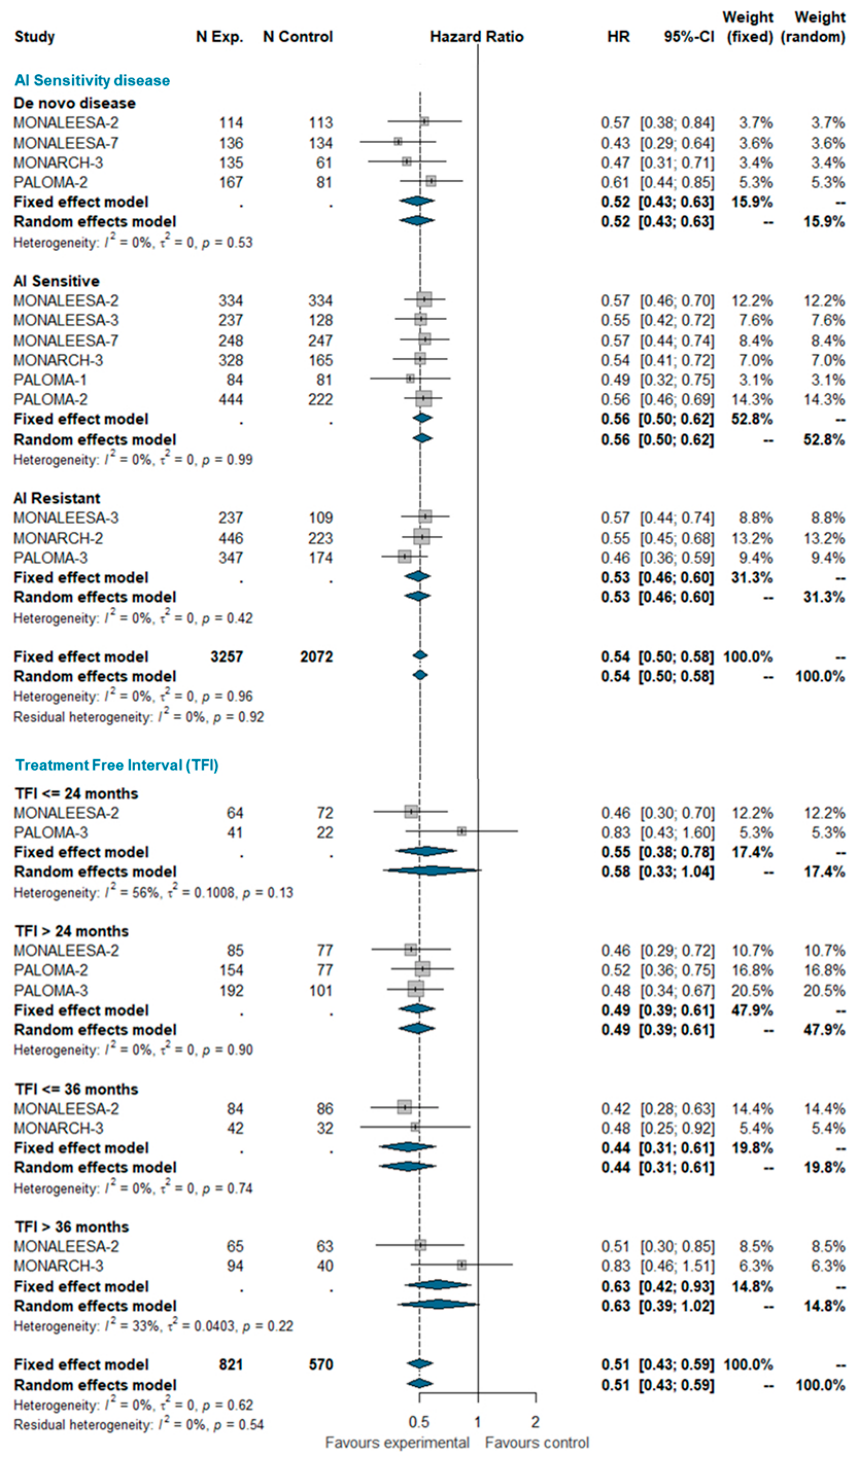
Figure 1. Pooled comparison of PFS according endocrine sensitivity (de novo disease, AI sensitive, AI resistant) and treatment-free interval (TFI <= 24 months, TFI > 24 months, TFI <= 36 months, TFI > 36 months). Abbreviations: PFS: progression free survival; N exp: number of patients randomized in experimental arm; N control: number of patients randomized in control arm; HR: hazard ratio; CI: confidence interval; AI: aromatase inhibitors; TFI: treatment free interval).